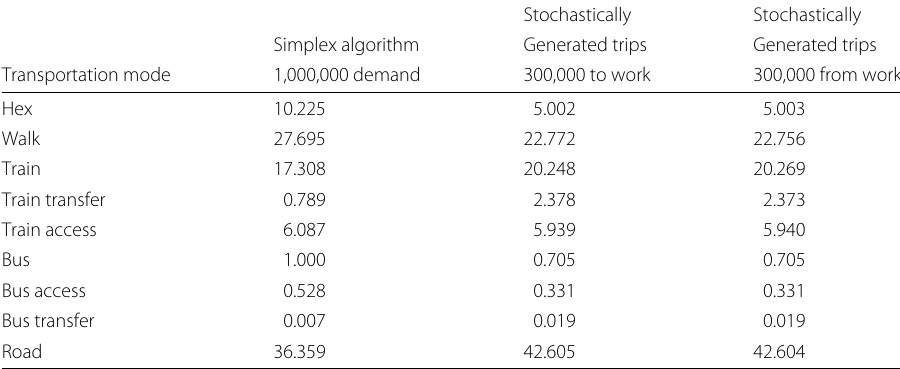
Table 3 Percents of the total usage frequency of links by modality for the three generated flow